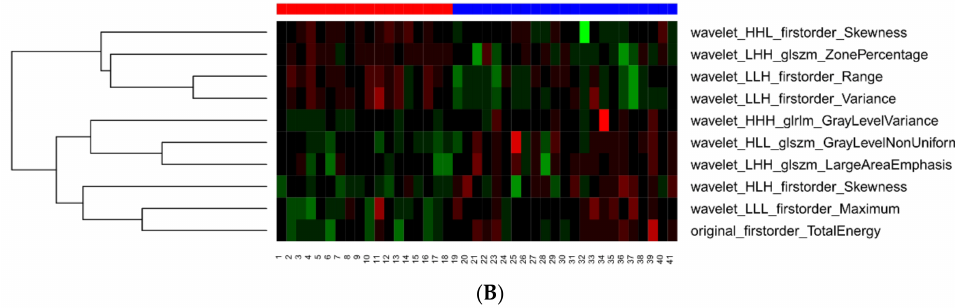
Figure 5. ( A ) AUC barplot showing AUCs of features used in the second model. ( B ) The 10 feature parameters and corresponding coefficients after screening in the second model in a heatmap.